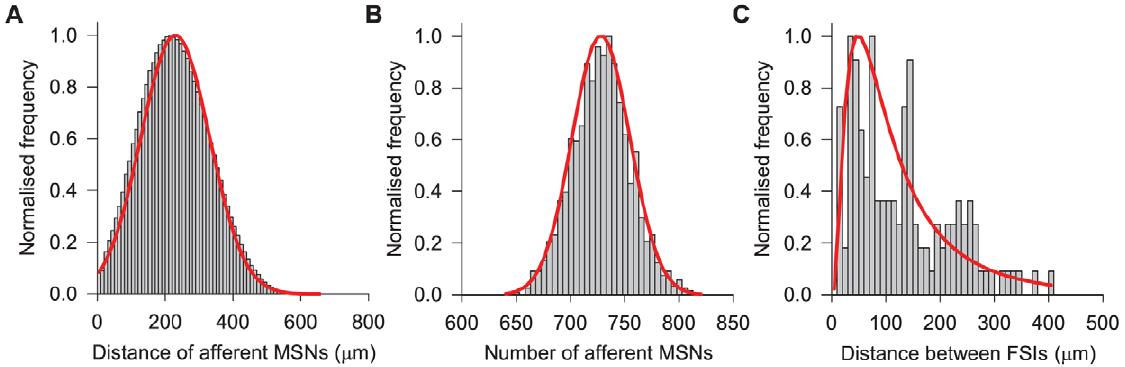
Figure 8. Model predictions for the statistics of striatal neuron connectivity. A Distribution of distances for MSN afferents to each MSN over all networks is approximately Gaussian (thick red line), truncated at the minimum enforced distance between neurons. B Distribution of number of afferent MSNs to each MSN is approximately Gaussian too. C The distances between gap-junction coupled FSIs follow a log-normal distribution, with half of all connections occurring between neurons less than 112 m m apart. (All data taken from 3% FSI networks. Histograms were compiled for 10 m m (panels A, C) or 5 neuron bins (panel B), and normalised to the maximum bin count.)